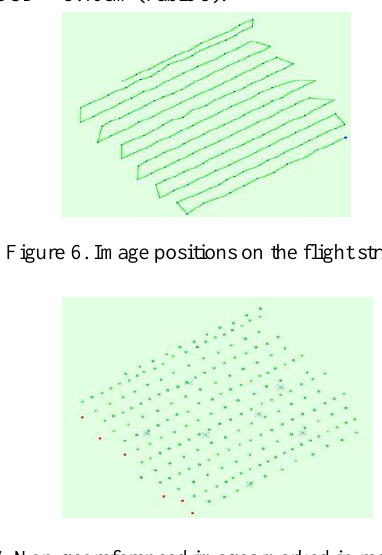
Figure 7. Non-georeferenced images marked in red on the left side of the rectangle, indicating the flight